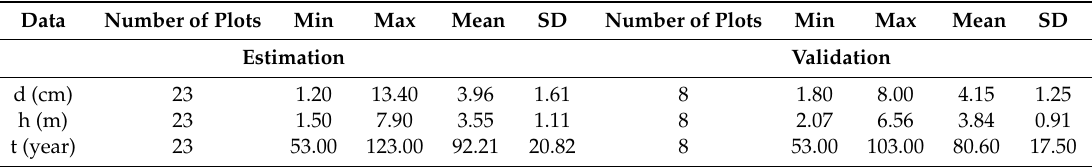
Table 5. Summary statistics.